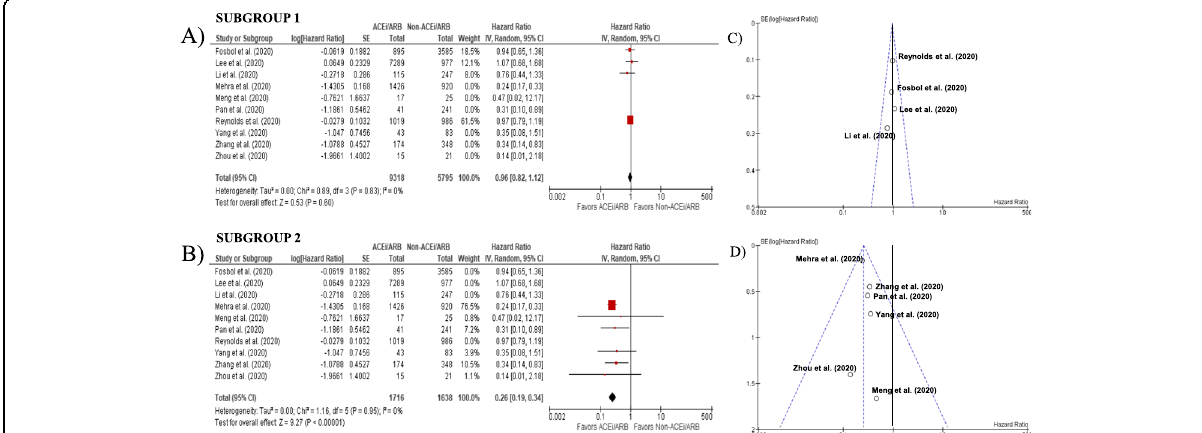
Fig. 3 Additional adjusted meta-analysis of studies in subgroup 1 a and subgroup 2 b . Estimate of subgroup 1 c and subgroup 2 d publication bias scattered in funnel